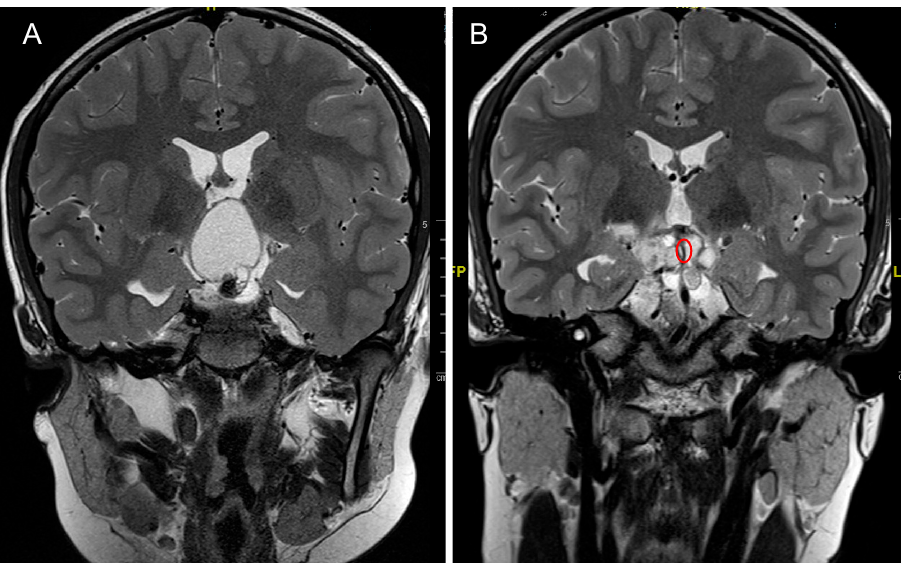
Figure 2. 12-year-old male, presenting with growth delay and obesity due to endocrine deficits caused by an adamantino- matous craniopharyngioma, Puget 2. ( A ) Preoperative coronal image showing a space-occupying cyst of the CP causing hydrocephalus. ( B ) Postoperative coronal image showing drained cyst and the tip of the inserted drain (red circle). The patient was then treated with proton beam therapy as an adjuvant treatment to surgery.